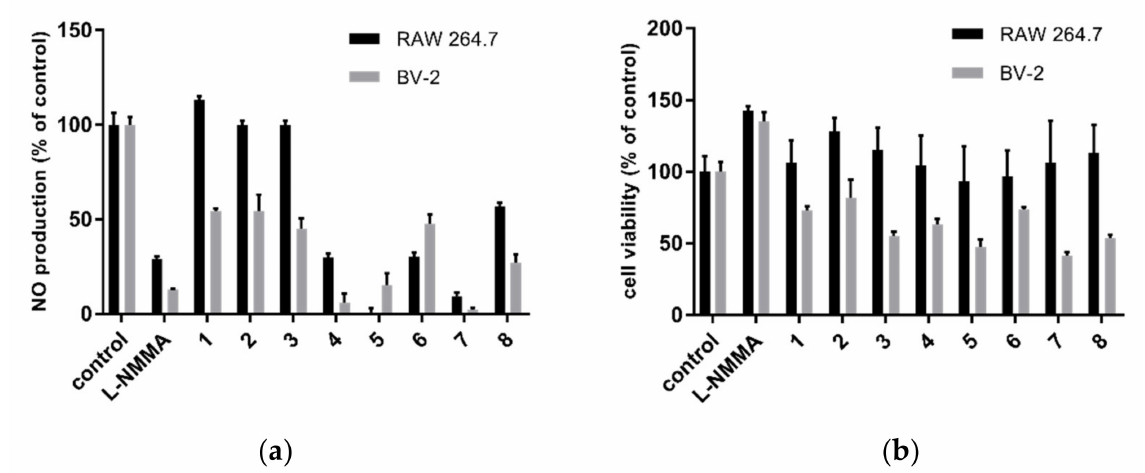
Figure 3. ( a ) NO production inhibitory effects and ( b ) cytotoxic properties of compounds 1 - 8 at a final concentration of 50 µ M in LPS-IFN- γ -induced RAW 264.7 macrophages and BV-2 microglial cells. L-NMMA was used as the positive control at 100 µ M. The NO inhibition of control group (LPS-IFN- γ -induced cells with 1% DMSO) was set as 100% ( n = 6).